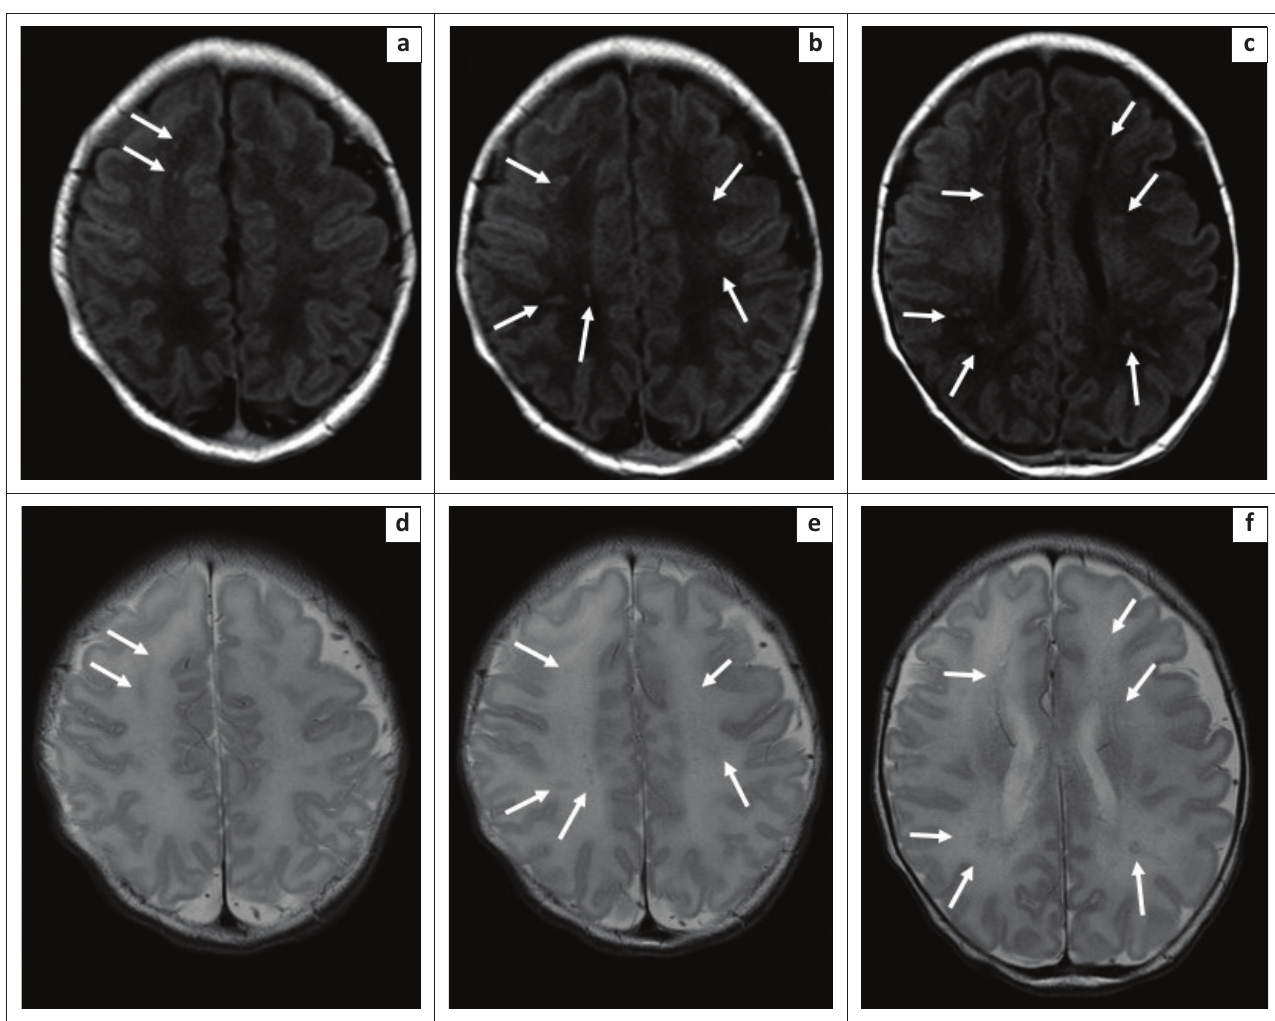
FIGURE 4: Axial unenhanced T1-weighted MRI of the brain (repetition time msec/echo time msec, 300/2.52, 3-mm section thickness) at the level of centrum semiovale and corona radiata (a, b, c) with corresponding axial T2-weighted MRI of the brain (repetition time msec/echo time msec, 3680/90, 3-mm section thickness) (d, e, f). There were areas of T1 and T2 shortening following the distribution of deep medullary veins (solid white arrows on all images), more evident on the T1-weighted